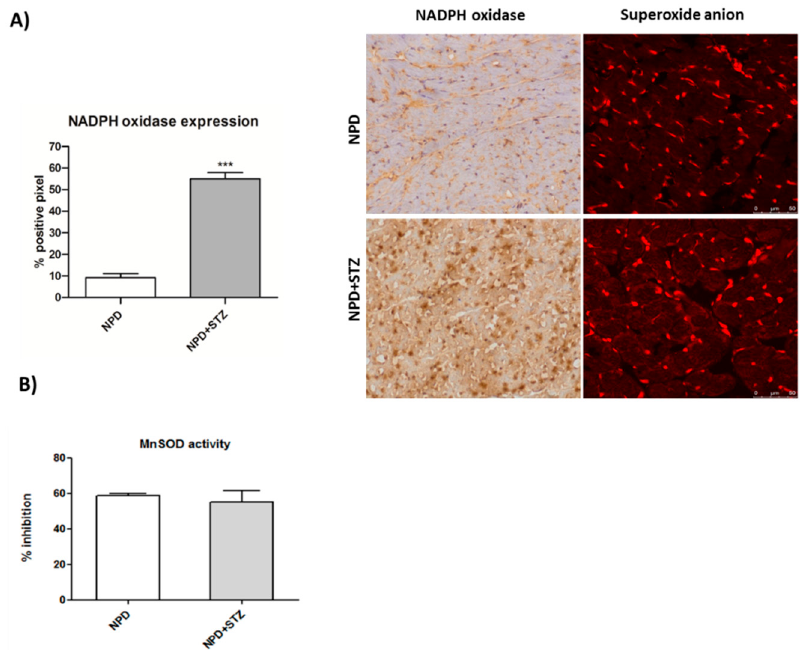
Figure 3. Effect of hyperglycaemia on NADPH oxidase expression and superoxide dismutase (SOD) activity in myocardial tissue. ( A ) In the STZ group, up ‐ regulation of NADPH oxidase was associated with higher detection of superoxide anion, compared with the NPD group. On the left, quantification of NADPH expression related to immunohistochemistry analysis and representative confocal images showing MitoSOX™ staining. Red fluorescence indicates the formation of superoxide anion. ( B ) SOD activity in mitochondrial fraction remained unchanged between the two groups. The data are presented as mean ± SEM. *** p < 0.001 vs. NPD, Mann–Whitney test, n = 6/group. Finally, TSPO expression was up-regulated in the hearts of NPD + STZ rats compared with NPD cardiac tissue (Figure 4A).